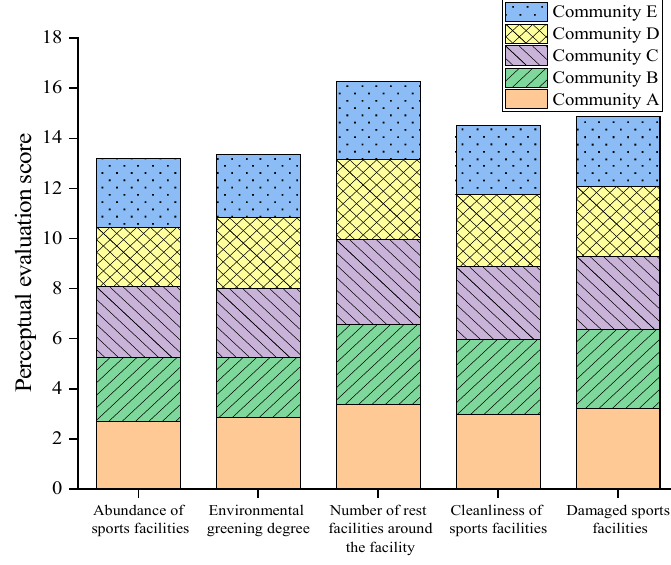
Figure 5. The physical environment perception evaluation score of each community.